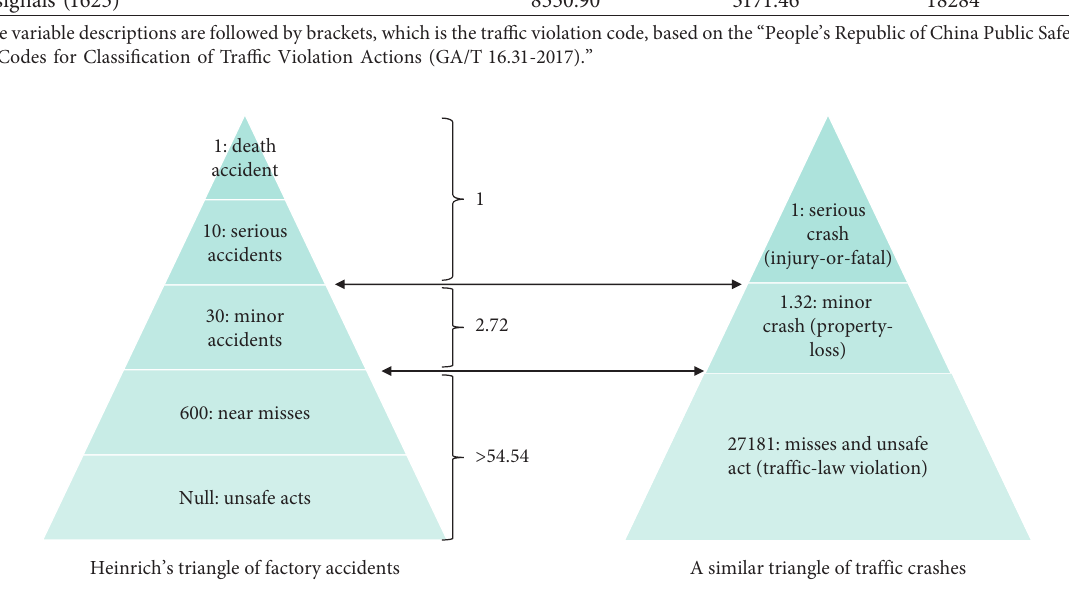
Figure 2: The comparison of Heinrich’s triangle between factory accidents and traffic crashes.